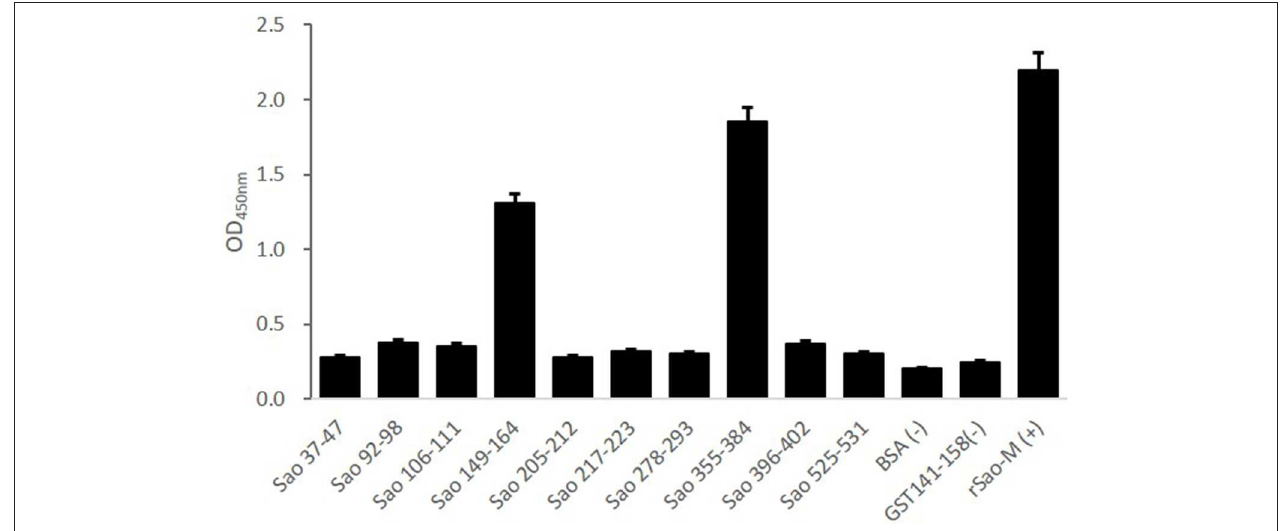
FIGURE 4 | ELISA detection of B cell epitope peptides of Sao-M. To determine the immunodominant epitope peptide of Sao-M, ELISA plate was coated with 10 synthetic peptides or GST 141 − 158 (negative control of irrelevant peptide) or rSao-M protein and BSA. Then, serum samples from BALB/c mice that were immunized with rSao-M plus Freund’s adjuvant were detected. The absorbance was read at 450nm. The absorbances at 450nm for the peptides Sao 355 − 384 and Sao 149 − 164 were significantly higher than GST 141 − 158 ( P < 0.0001) and BSA ( P < 0.0001). Of these two immunodominant epitope peptides, Sao 355 − 384 had the stronger response.